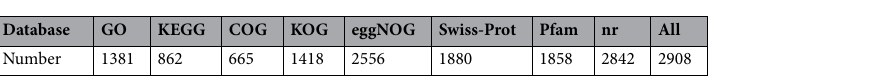
Table 4. Functional annotation of